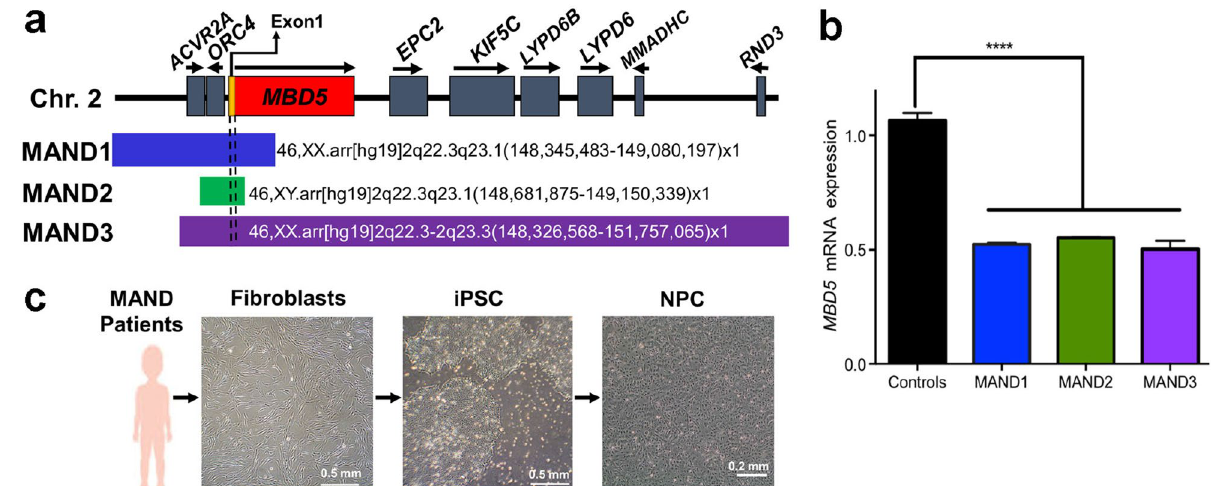
Figure 1. MAND patient 2q23.1 deletions include MBD5 and exhibit reduced MBD5 expression indicating haploinsufficiency. ( a ) Schematic diagram of the chromosome 2q23.1 deletion region. The coding region of MBD5 is indicated by the red box; yellow region indicates non-coding exons. Chromosome 2q23.1 deletions present in the MAND patients in this study are summarized with bars. Additional details regarding MAND patients are provided in Supplementary Table 1. ( b ) qRT-PCR analysis showed ~ 50% reduction of MBD5 mRNA expression in primary fibroblasts derived the three MAND patients compared to the controls. Expression of MBD5 was calculated relative to that of the housekeeping gene, GAPDH . All expression values were calculated relative to control levels set at 1.0. Error bars represent the SEM. **** p < 0.0001, n = 3 independent biological replicates performed in triplicate, GraphPad Prism 8.4.2 (graphpad.com). ( c ) Overview of iPSC and neural progenitor cell (NPC) line derivations in this study. Skin fibroblasts from MAND patients (bar, 0.5 mm)